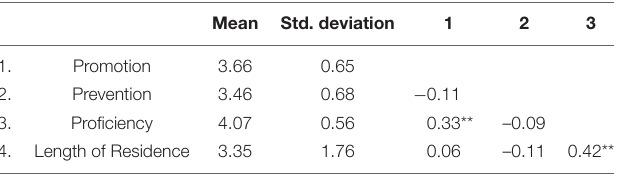
TABLE 2 | Pearson correlations between predictor variables.